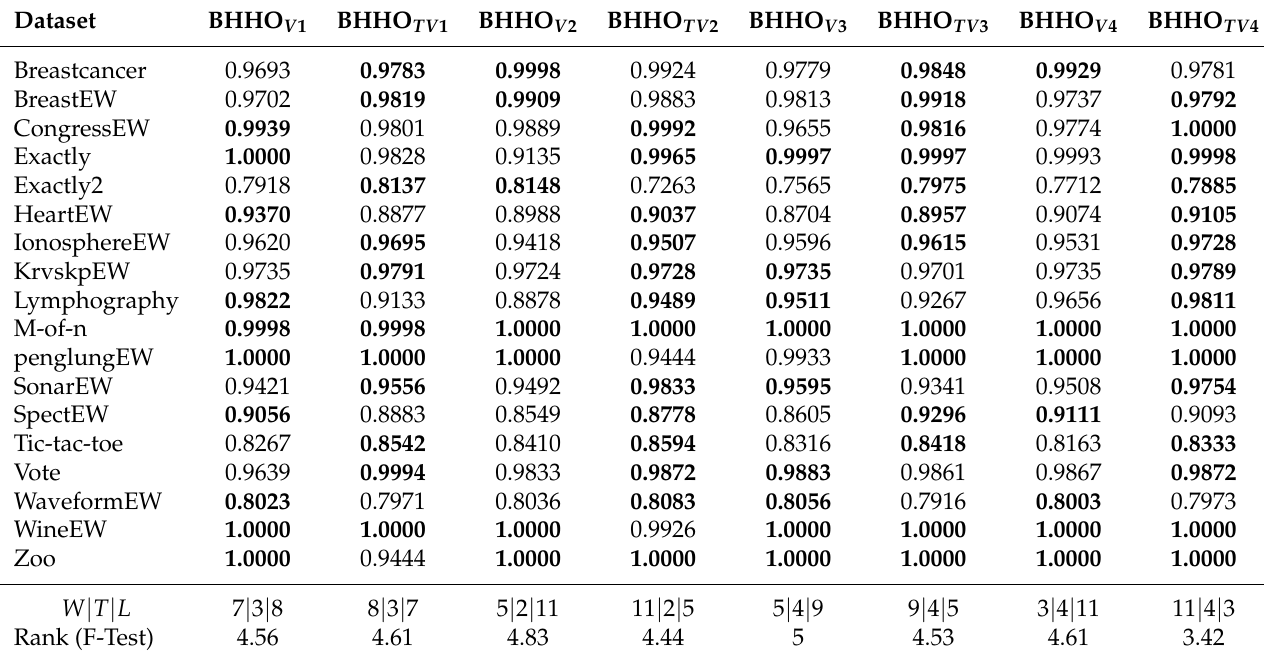
Table 4. Comparison of BHHO with the basic and time-varying V-shaped variants in terms of accuracy